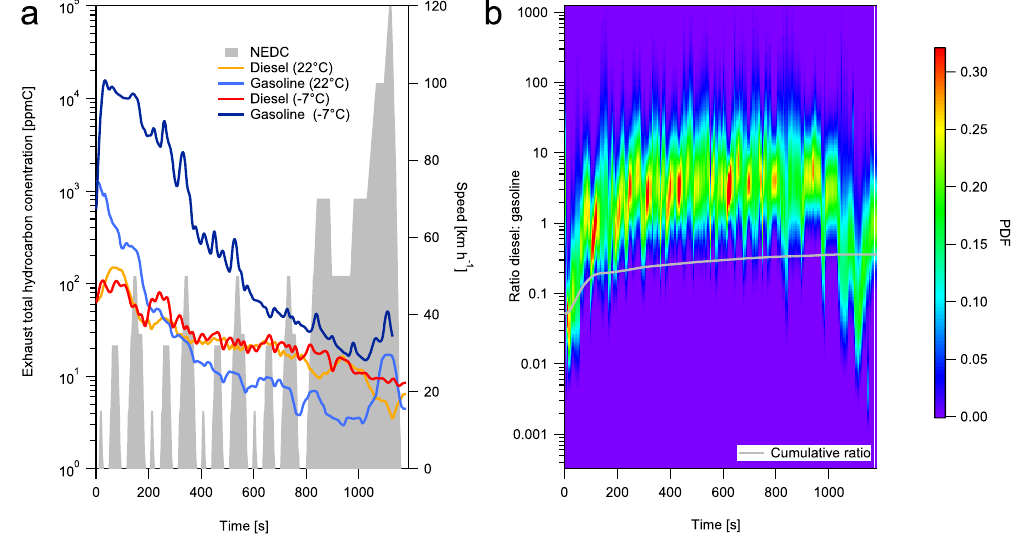
Figure 4. Time resolved exhaust total hydrocarbon (THC) concentrations from Euro 5 gasoline (number vehicles, n = 11) and diesel (n = 6) passenger cars. ( a ) Median time-resolved THC exhaust concentrations in the diesel and gasoline passenger car exhausts during the NEDC driving cycle, at − 7 and 22 °C (target speed, grey shaded region) ( b ) Ratio of the distributions whose medians are given in A, shown as a probability density function (PDF, colour scale), for the 22 °C case. While the ratio of diesel to gasoline exhaust THC is broadly distributed ( > factor 10) and variable, particularly during initial operations at higher speed, the difference is still statistically significant. The grey line gives the time-integrated median of the distribution (i.e. from the test start to the denoted time, lower than the time-resolved ratio for much of the cycle due to the high absolute concentrations and low gasoline:diesel THC during the cold start, and below unity, indicating that total gasoline exhaust THC emissions are higher). Note the logarithmic scale in both panels. While THC emissions from diesel cars are up to one order of magnitude higher than gasoline emissions during almost the entire driving period, gasoline emissions are up to two orders of magnitudes higher when the catalyst is cold. Because of the cold start effect, integrated emissions from gasoline cars exceed diesel, even after a journey of several kilometres (~14 km). This effect is more pronounced at − 7 °C (SI Fig.